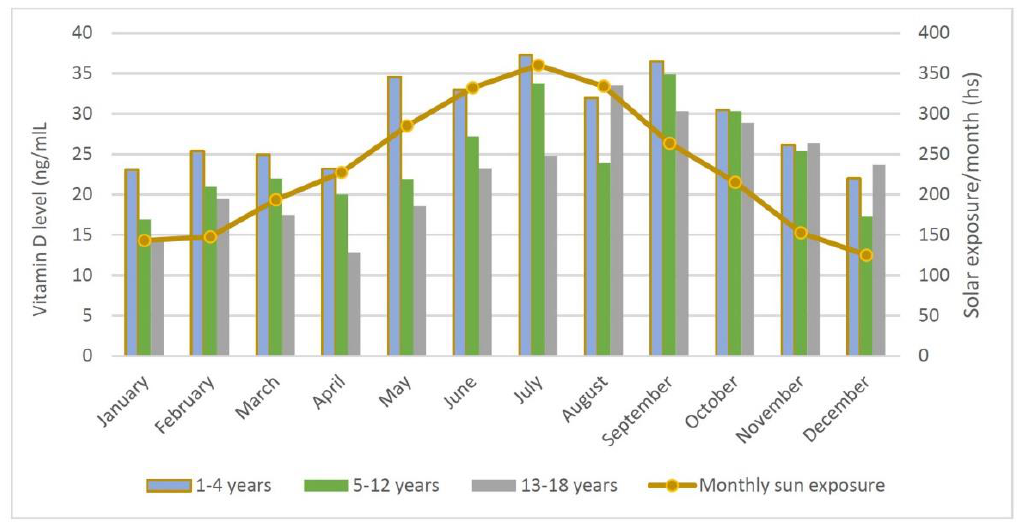
Figure 2. Mean serum concentration of 25(OH)D (ng/mL) in healthy children in Greece ( n = 376), according to month and age, depending on the mean monthly hours of sunshine.